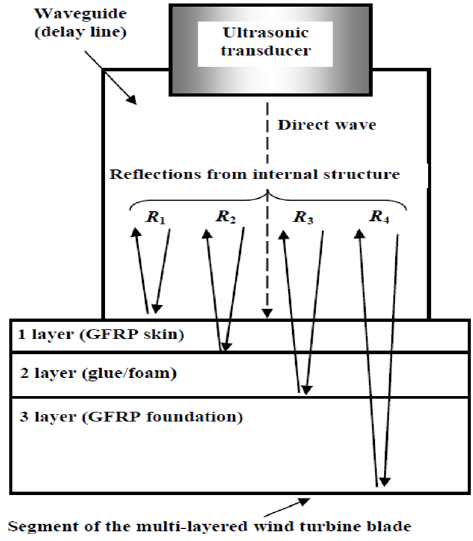
Figure 16. Ultrasonic technique [48].